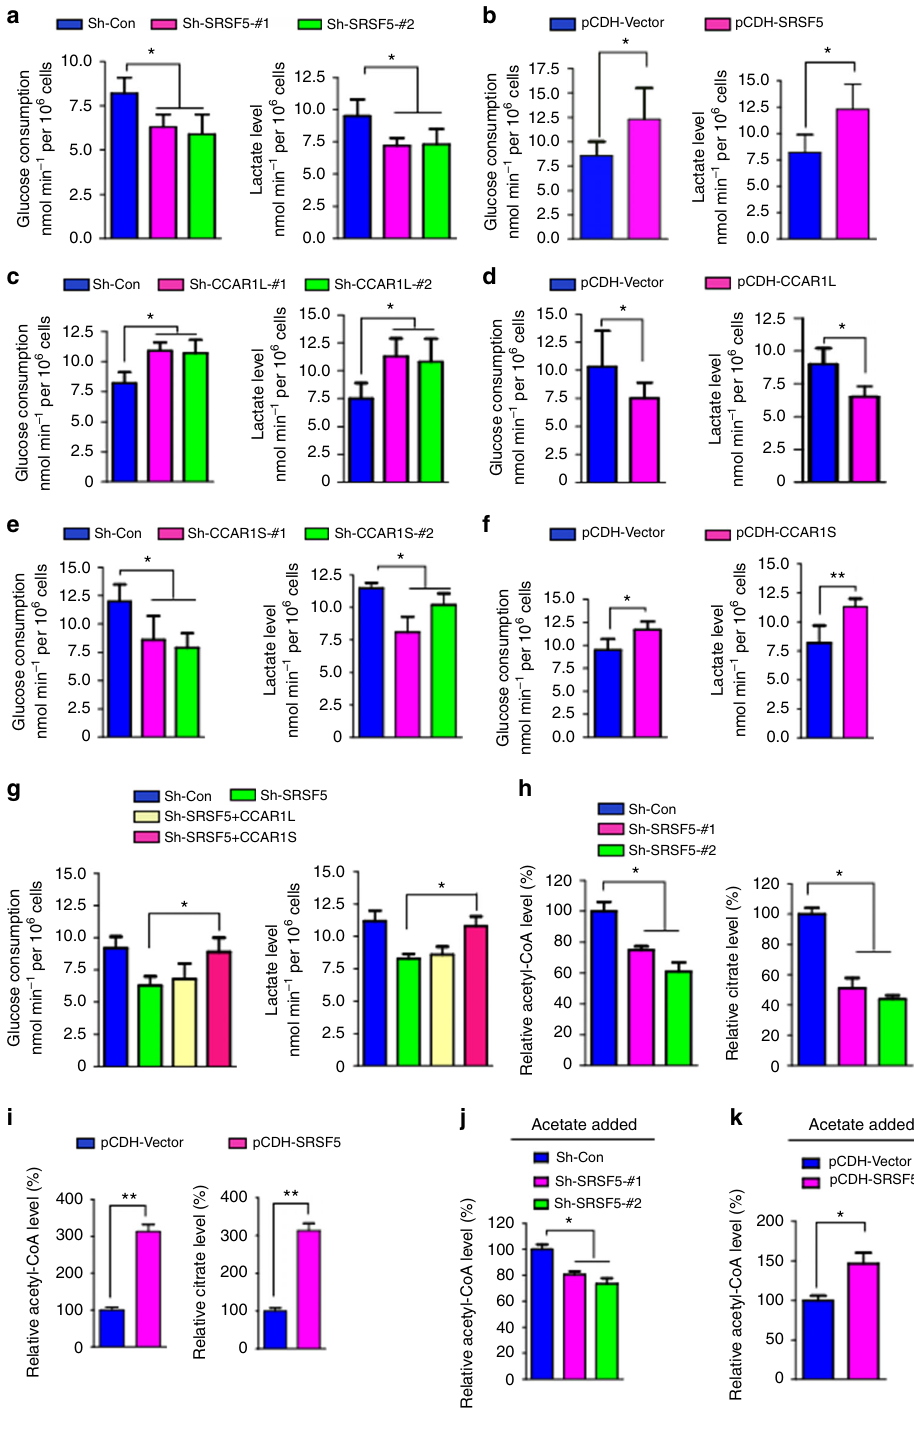
Fig. 4 SRSF5 regulates glucose metabolism and acetyl-CoA production. a Analysis of glucose consumption rate and lactate production levels in SRSF5-depleted and control A549 cells. b Analysis of glucose consumption rate and lactate production levels in SRSF5-overexpressed and control A549 cells. c Analysis of glucose consumption rate and lactate production levels in CCAR1L-depleted and control A549 cells. d Analysis of glucose consumption rate and lactate production levels in CCAR1L-overexpressed cells. e Analysis of glucose consumption rate and lactate production levels in CCAR1S-depleted and control cells. f Analysis of glucose consumption rate and lactate production levels in CCAR1S-overexpressed cells. g Measurement of glucose consumption rate and lactate production levels in the cells described in Fig. 2k. h Acetyl-CoA levels and citrate levels in SRSF5-depleted and control A549 cells in high glucose. i Acetyl-CoA levels and citrate levels in SRSF5-overexpressed and control cells. j A549 cells depleted of SRSF5 were administrated to 5mM acetate treatment and the relative acetyl-CoA level and citrate level were monitored. k A549 cells over-expressing SRSF5 were administrated to 5mM acetate treatment and the relative acetyl-CoA level and citrate level were monitored. Data are representative of three independent biological replicates. All data are mean and s.e.m., n = 3. * P <0.05 and ** P <0.01 (one-way ANOVA